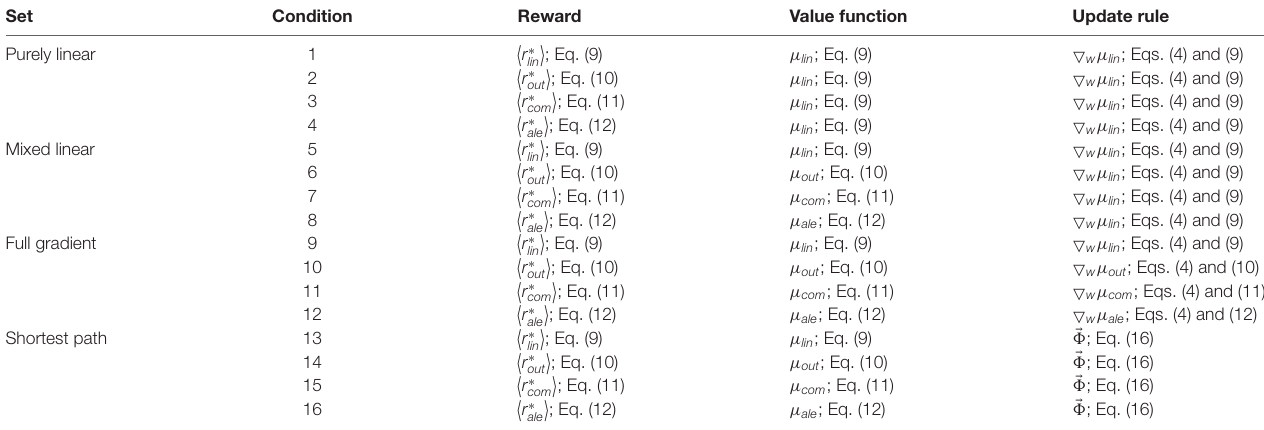
TABLE 1 | Conditions simulated.